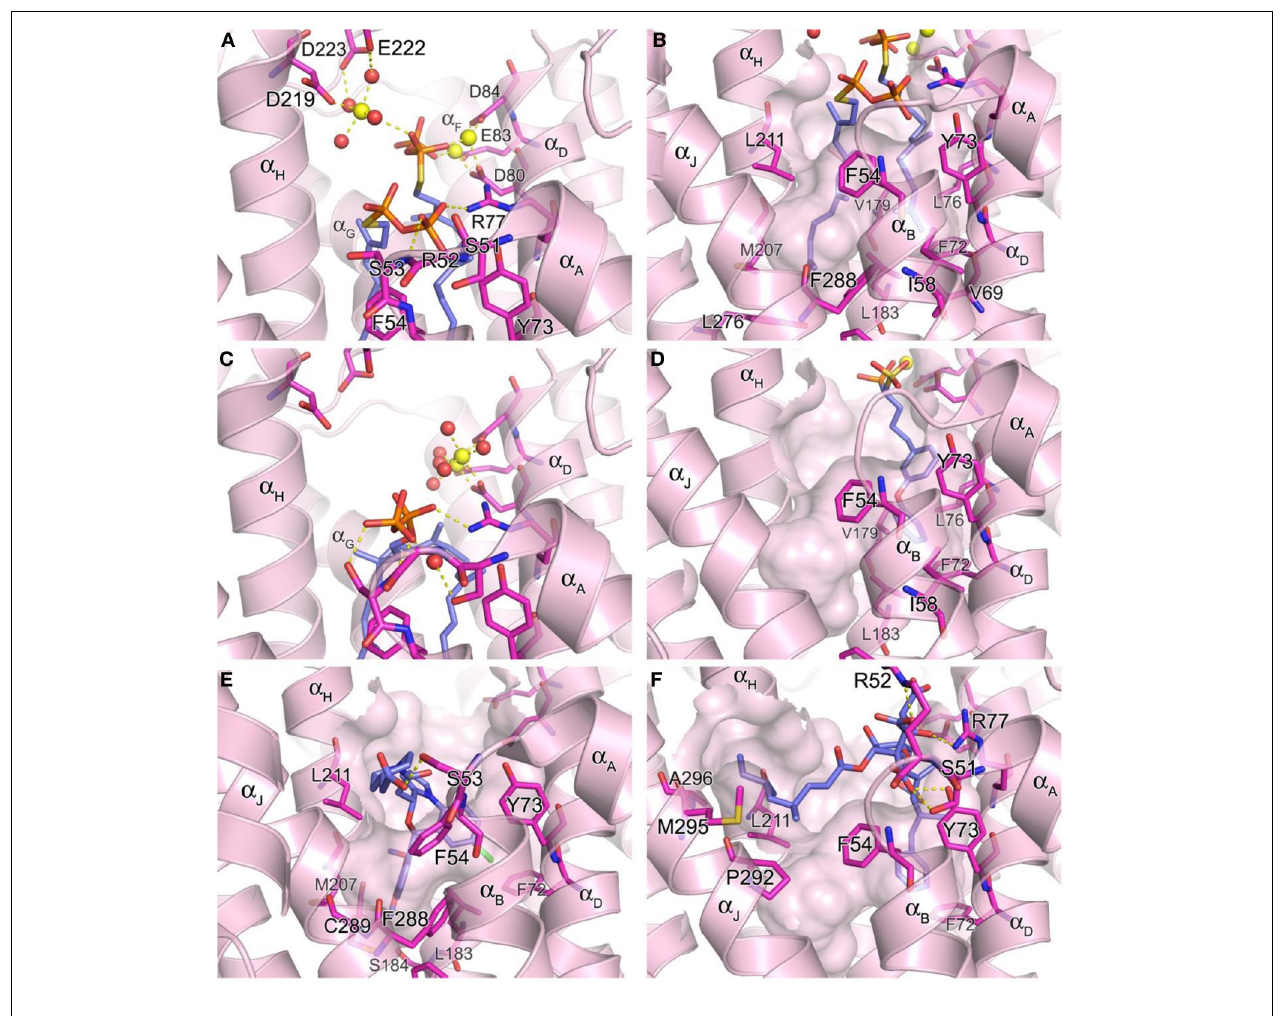
the same orientation as in (A) (PDB ID: 3WEH). For clarity of the view, residues (redundant with those in A ) are not labeled. (D) Binding of a bisphosphonate inhibitor, compound 27 (PDB ID: 3LEE). (E) Binding of a benzoxazepine inhibitor, compound 49 (PDB ID: 3V66). (F) Binding of zaragozic acid A ( 38 ) (PDB ID: